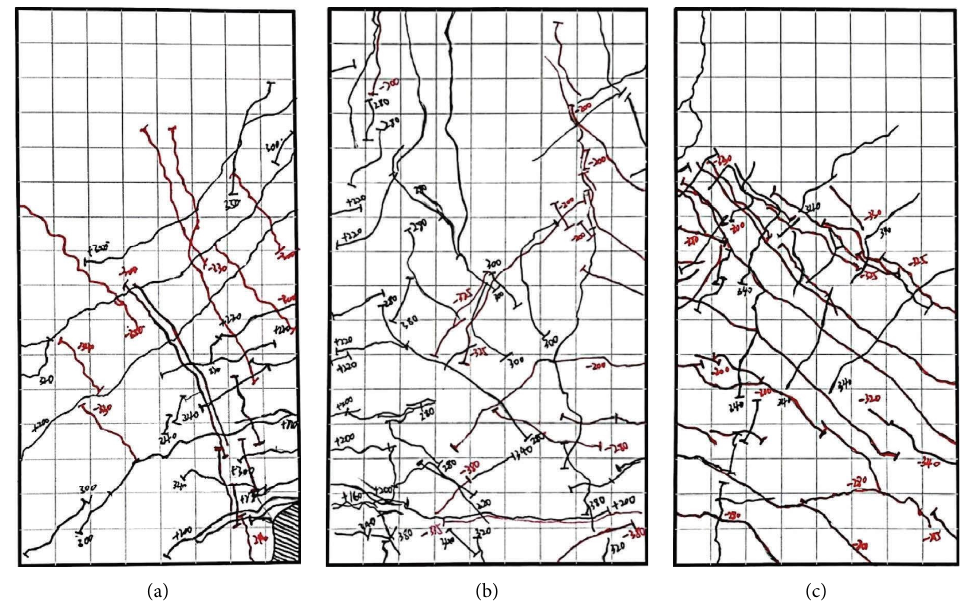
Figure 14: Damage results of URC-X specimen. (a) Wall limb 1. (b) Web. (c) Wall limb 2.